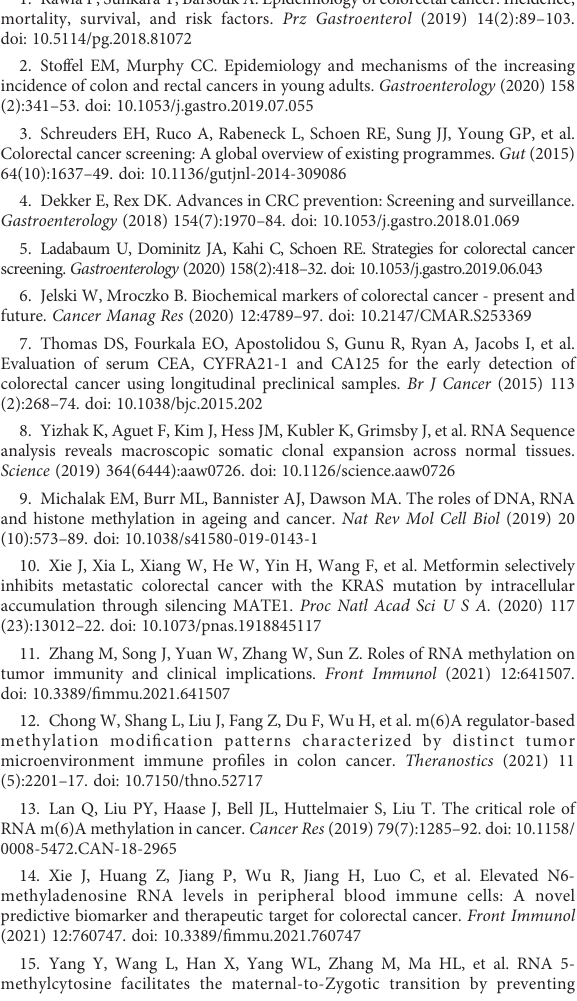
Comparison of blood m 5 C levels in CRC patients with (n=11) and without (n=51) distant-metastasis in the validation set. (C) Correlation SUPPLEMENTARY FIGURE 2 Clinical utility of m 5 C modi fi cation for the diagnosis of CRC in the validation set. (A, B) Cutoff value for m 5 C modi fi cation of peripheral